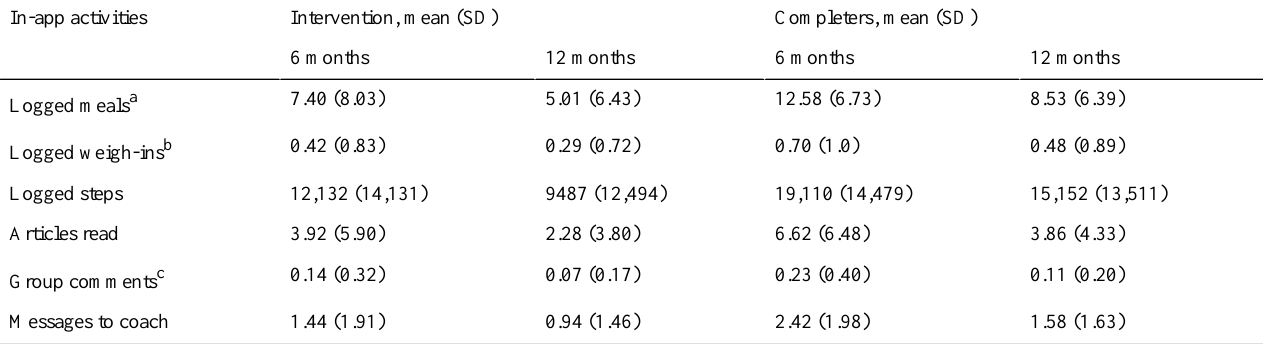
Table 3. Engagement of intervention participants (in-app actions per week as).